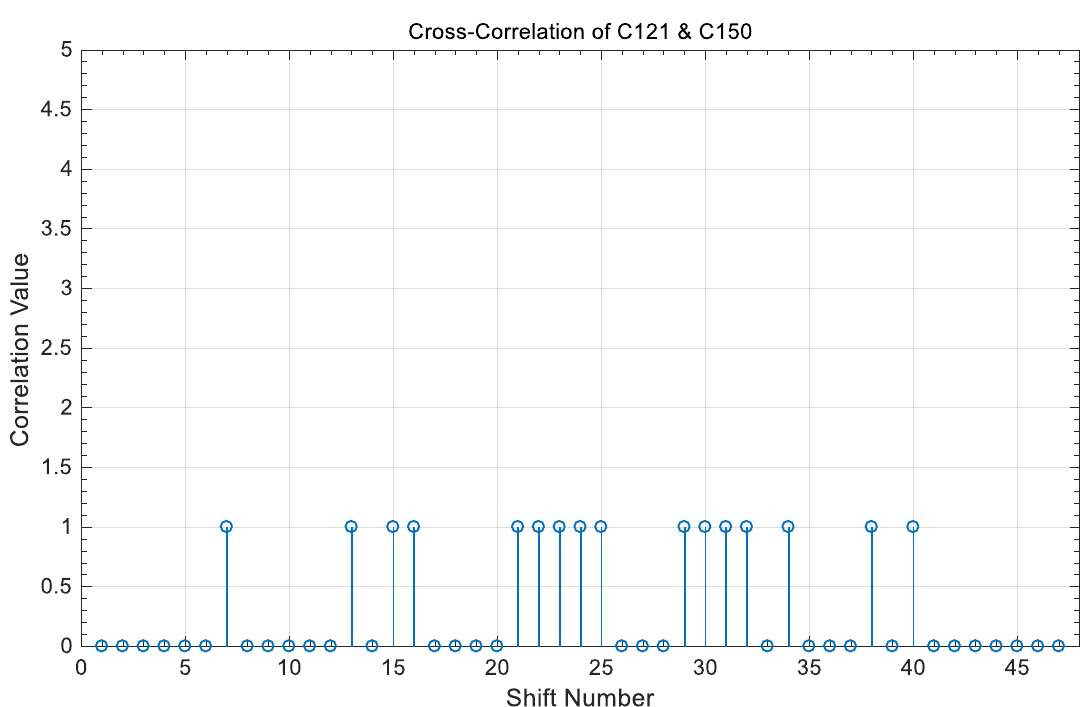
Figure 18. Cross-correlation between 𝐶 121 and 𝐶 150 sequences from different groups, 𝑃 1 = 5 and 𝑃 2 = 7.